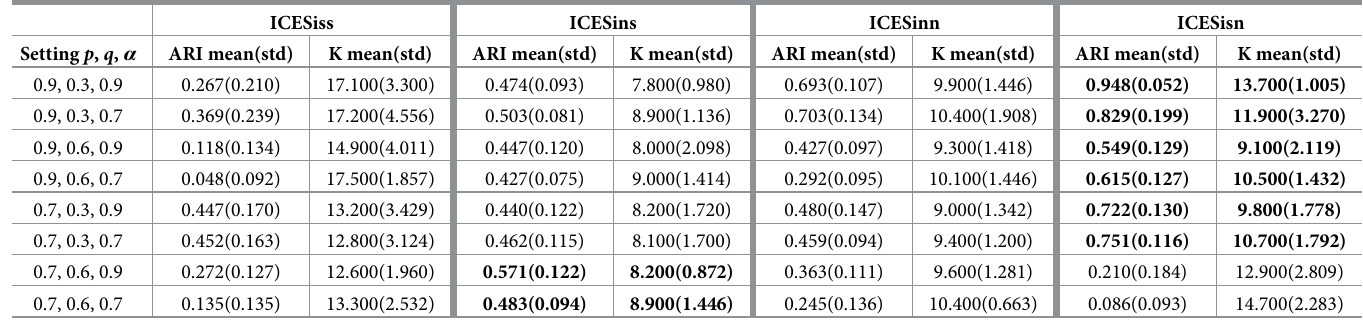
Table 16. The performance of ICESi methods at medium-size networks with quantitative features at the nodes with 50% noise features replicated; with selected data pre-processing for each algorithm: The average ARI index and its standard deviation over 10 different data sets. ICESiss ICESins ICESinn ICESisn Setting p , q ,